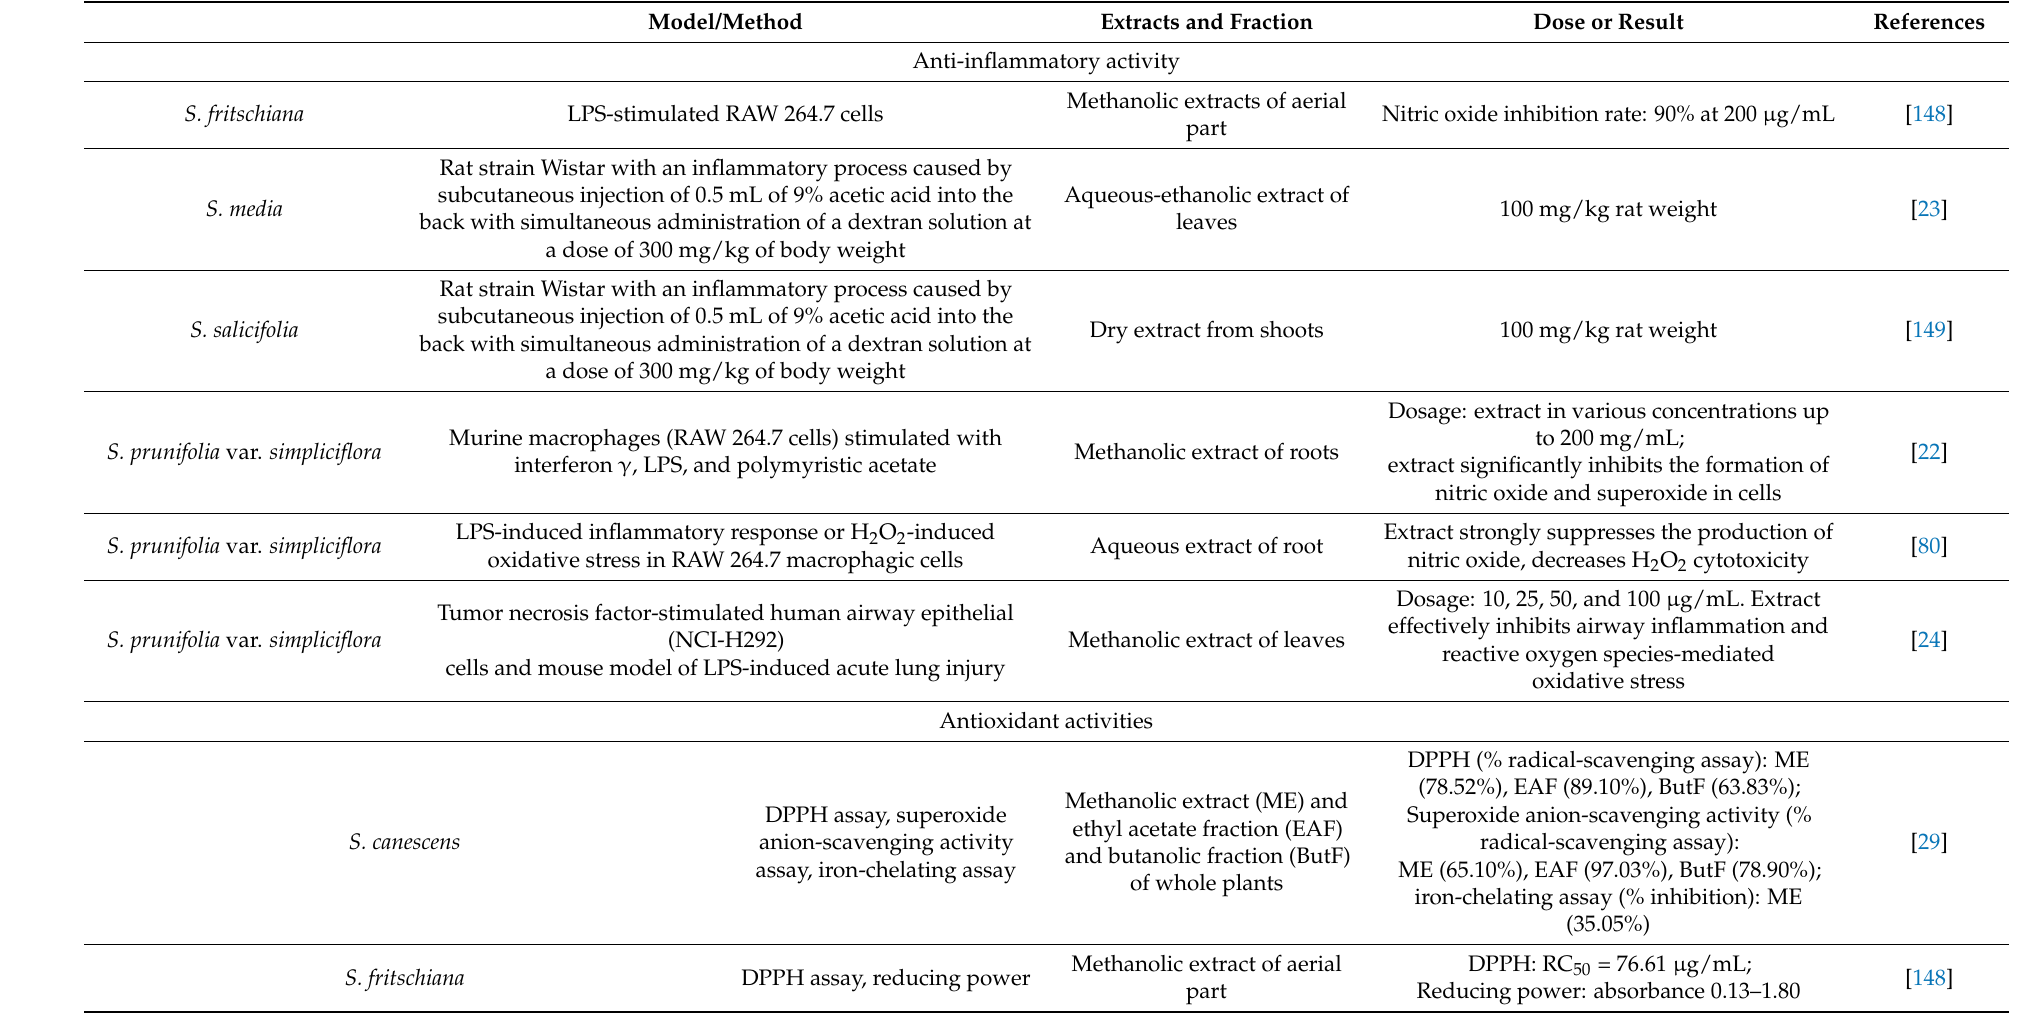
Table 3. Bioactive effects of spireas: preclinical (in vitro and in vivo)